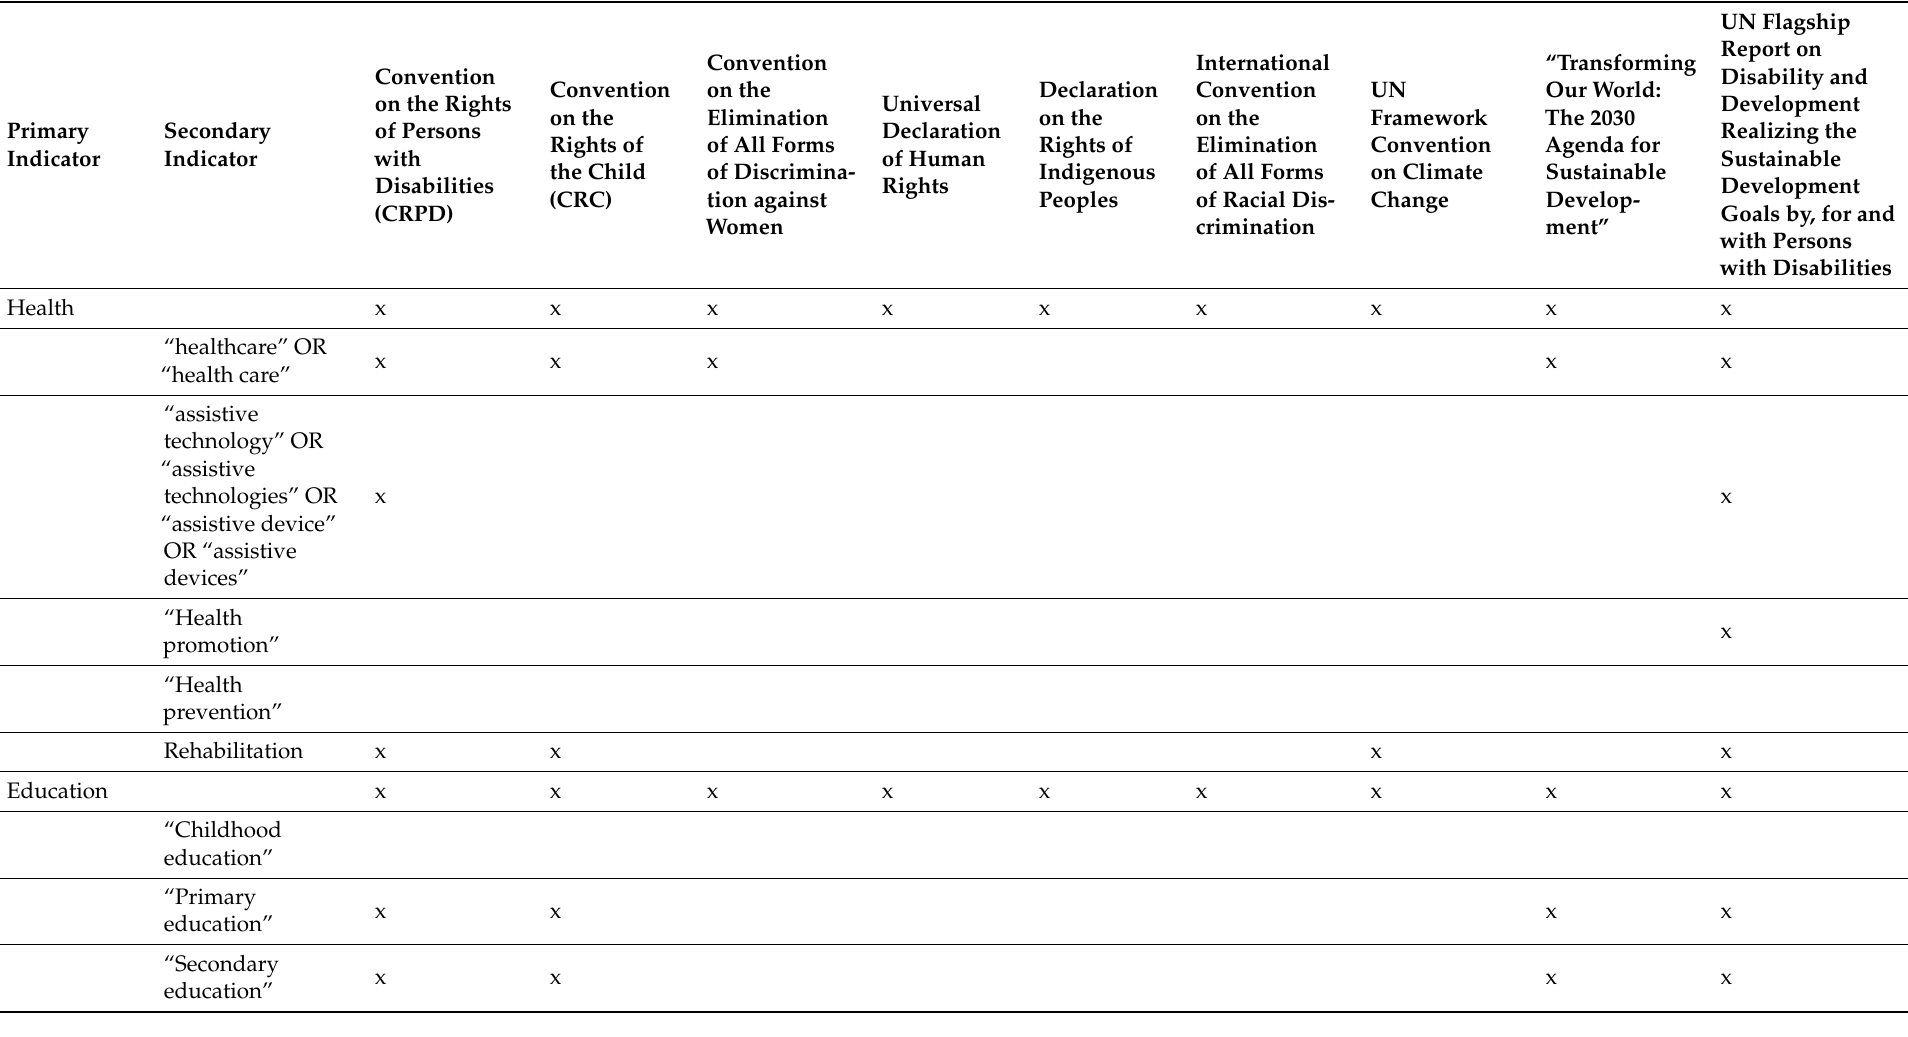
Table 5. Presence of Community Based Rehabilitation Matrix indicators in the actual document such as the